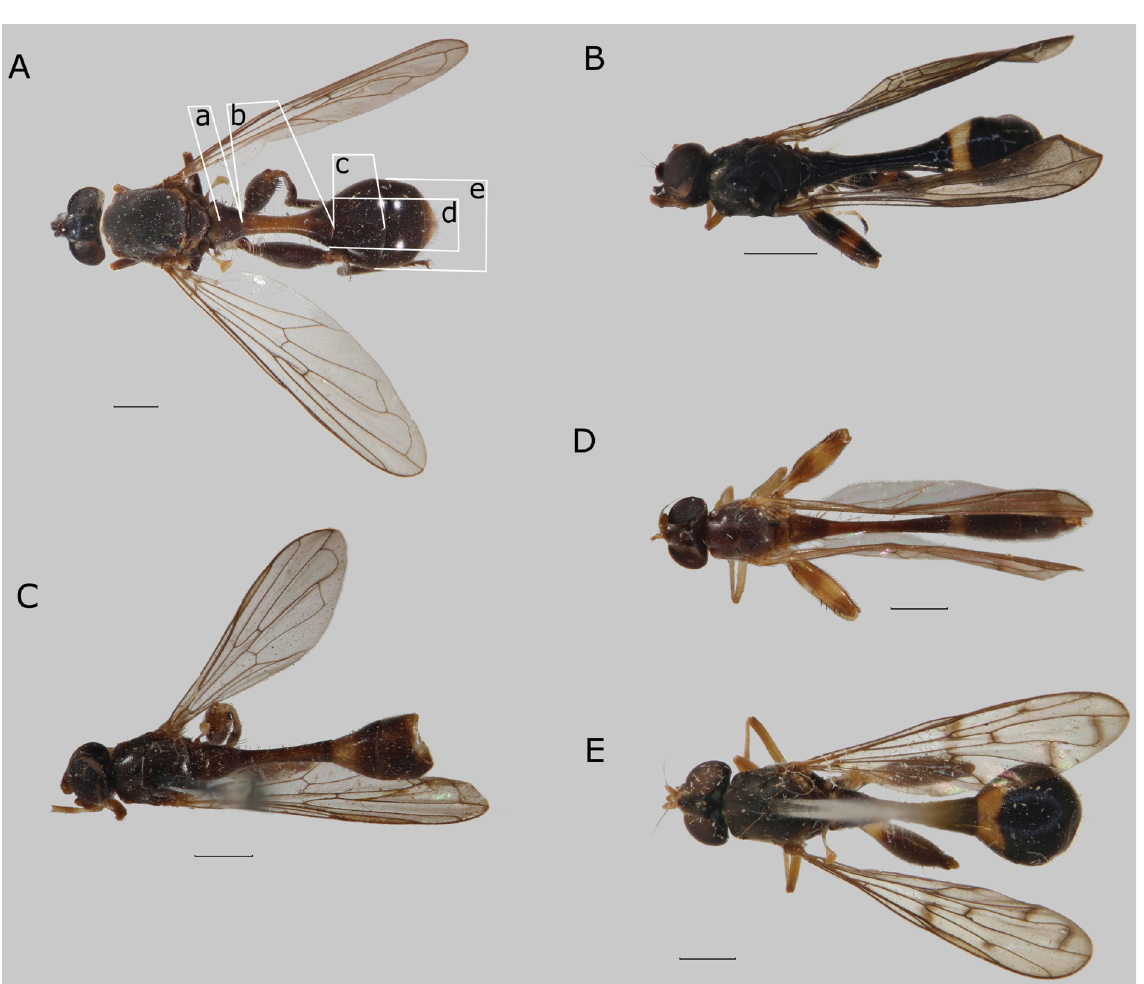
Fig. 10. Habitus, dorsal view. A . Sphegina (Asiosphegina) adusta Hippa, van Steenis & Mutin,2015, paratype, ♀ , Myanmar. B . S. (A.) apicalis Shiraki, 1930, ♂ , Taiwan. C . S. ( A. ) atricolor Hippa, van Steenis & Mutin, 2015, paratype, ♂ , Myanmar. D . S. (A.) bidens Hippa, van Steenis & Mutin, 2015, paratype, ♂ , Myanmar. E . S. (A.) carinata Hippa, van Steenis & Mutin, 2015, ♀ , India. Abbreviations: a, b, c are length of terga I, II and III, respectively; d, e are width of terga II and III, respectively. Scale bars = 1.0